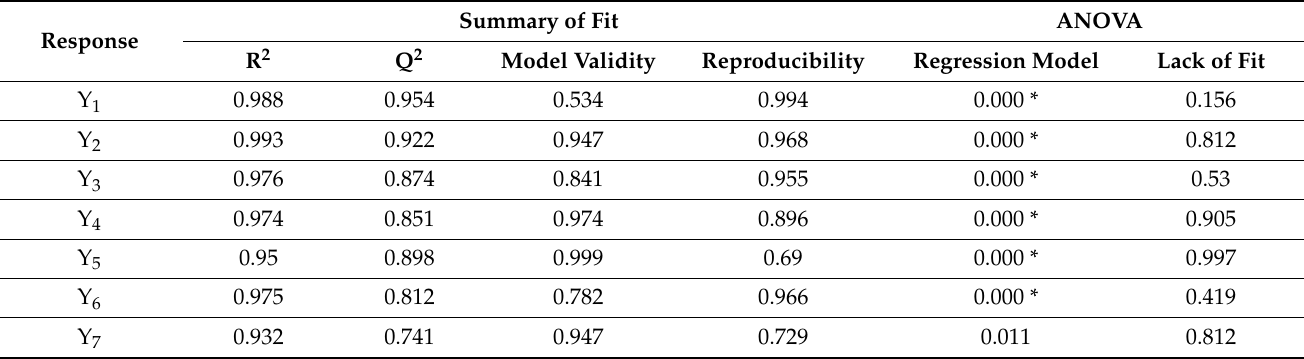
Table 2. The statistical parameters of the